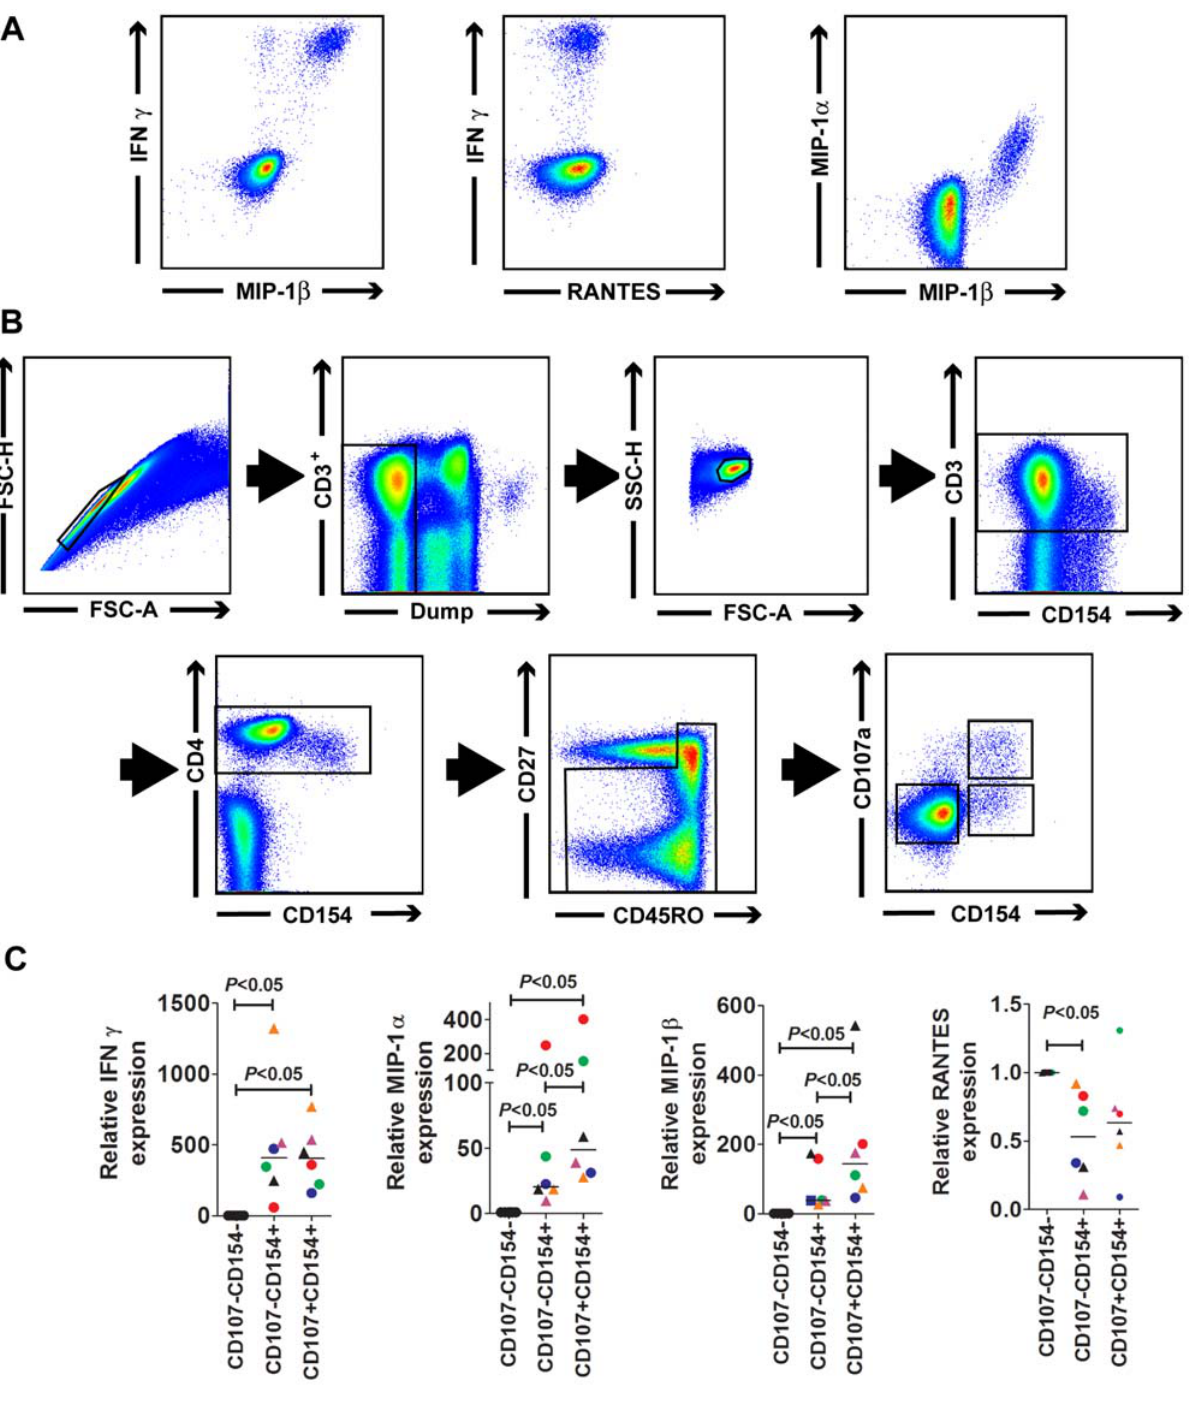
Figure 4. Stimulation of pp65-specific CD4 + T cells increased production of stainable IFN c , MIP-1 a and MIP-1 b and their respective mRNA, but not RANTES and its mRNA. A) A plot of CD4 + T cells stimulated with overlapping pp65 15mers shows populations of pp65-specific cells which stain for IFN c vs MIP-1 b , IFN c vs RANTES and MIP-1 a vs. MIP-1 b . Although staining for MIP-1 a and MIP-1 b were clearly visible, no evidence of RANTES staining was apparent. B) PBMC were incubated with overlapping pp65 peptides, anti-CD154 PE, anti-CD107a Alexa680 and monensin for 5 hr. Cells were then stained as described in Materials and Methods, and live CD14 2 CD19 2 CD3 + CD8 2 CD4 + memory cells were sorted into CD107 2 CD154 2 , CD107 2 CD154 + and CD107 + CD154 + populations as shown. C) The relative expression of IFN c mRNA, MIP-1 a mRNA, and MIP-1 b mRNA were all increased compared to the constitutively expressed glucuronide synthetase mRNA in pp65-specific cells ( P , 0.05). Expression of IFN c mRNA was no higher in pp65-specific cells which surface mobilized CD107a than in cells that did not surface mobilize CD107a. The ratio of MIP-1 a mRNA, and MIP-1 b mRNA to hGUS were increased in pp65 specific cells which surface mobilized CD107a compared to those which did not ( P , 0.05). RANTES mRNA was decreased in pp65-specific cells. Results from individuals are color coded. HIV-uninfected individuals are represented with circles; HIV-infected individuals are represented with triangles.